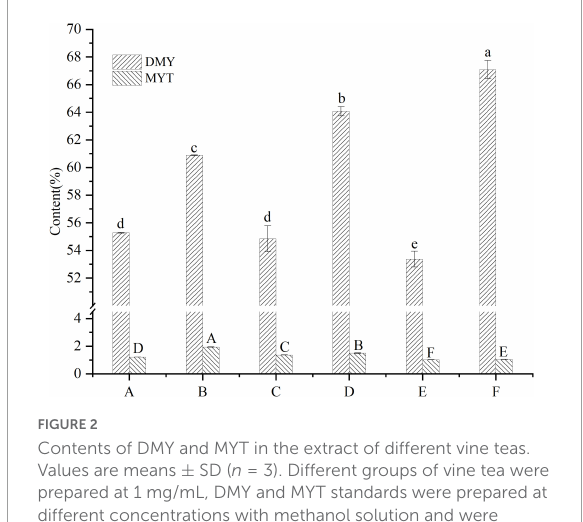
TABLE 1 Correlation analysis.